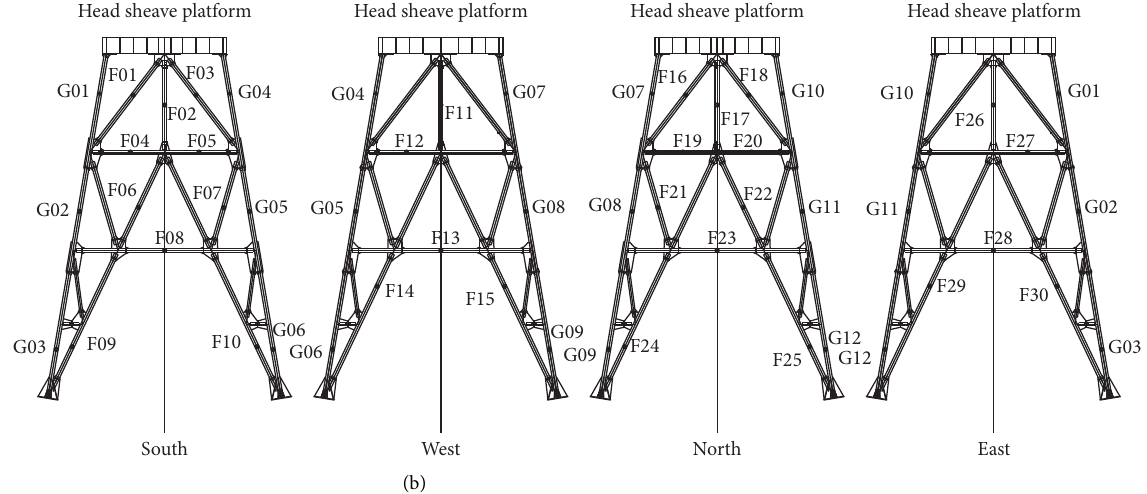
Figure 3: Number and corresponding positions. (a) Sheave wheel platform. (b) Headframe.